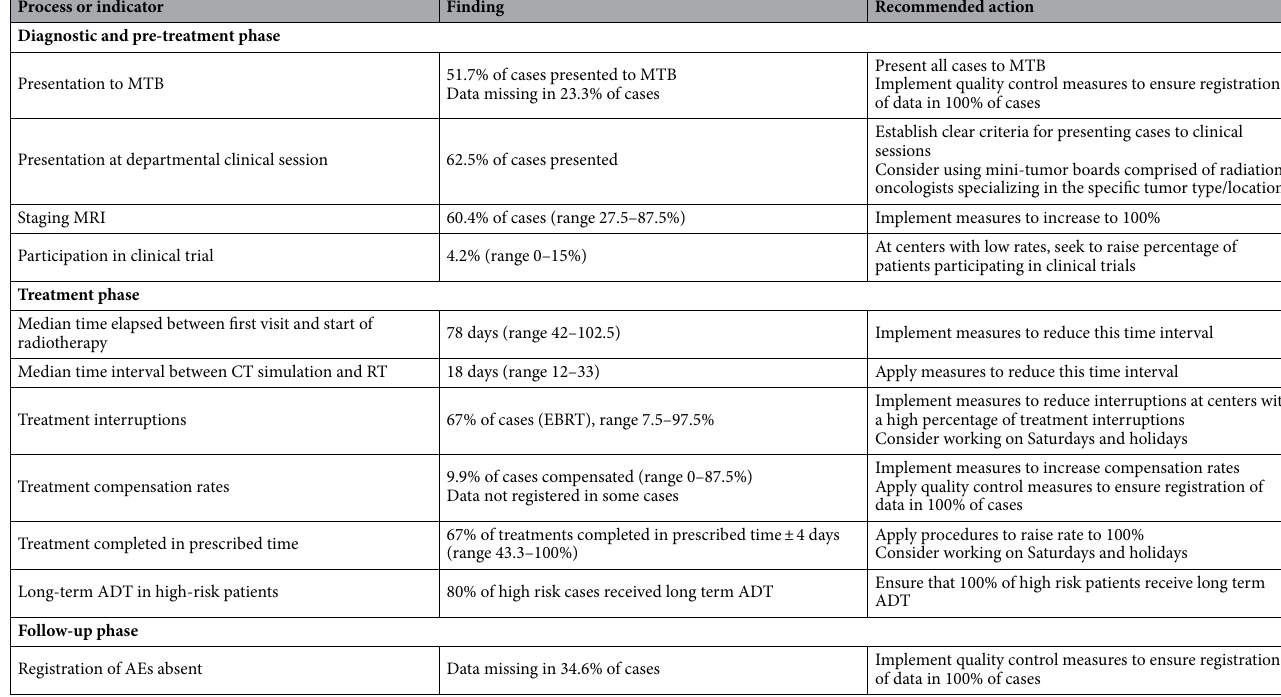
Table 2. Recommended steps for improvement and/or harmonization selected indicators/processes. MTB multidisciplinary tumor board, MRI magnetic resonance imaging, CT computed tomography, ADT androgen deprivation therapy, AE adverse events, RT